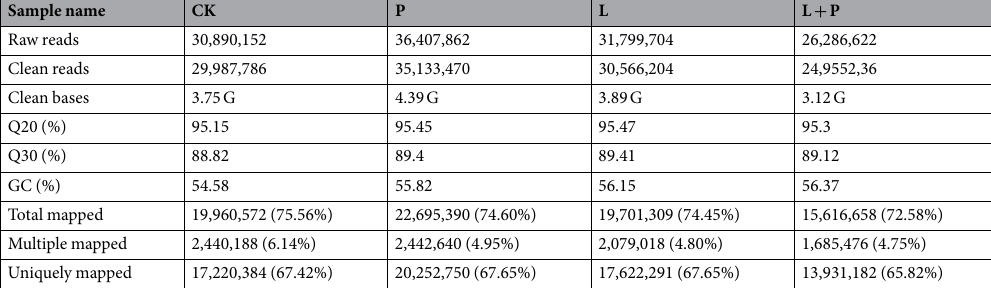
Table 2. Summary of RNA-seq data and reads mapping. Different treatment represents: The control (CK), natural drought stress (P), 3 min laser radiation (L), 3 min laser radiation + natural drought stress (L + P).